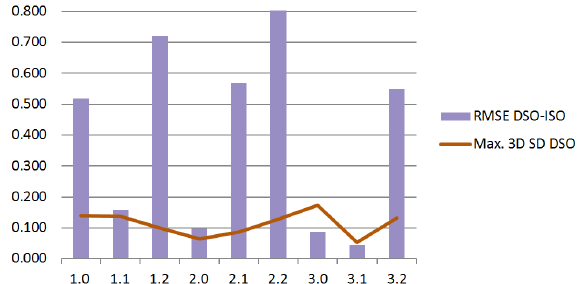
Figure 5. Comparison of RMSE values in m for 3D deviations of projection centers between direct and image-based georeferencing as well as maximum 3D position estimates from direct georeferencing